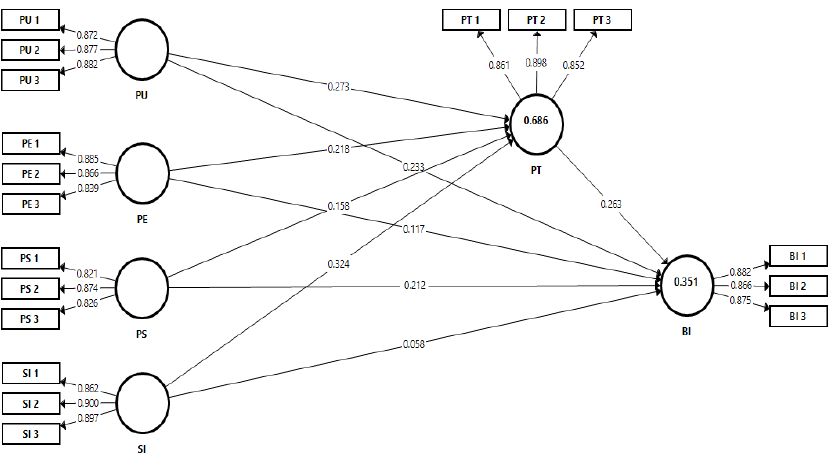
Fig. 1. Measurement